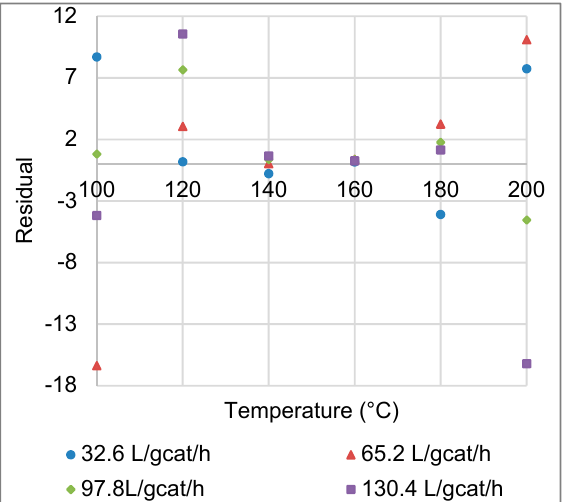
Figure A1. Residuals between experimental and modelled CO conversions, as a function of reaction temperature (Data are combined for the four space velocities investigated.).